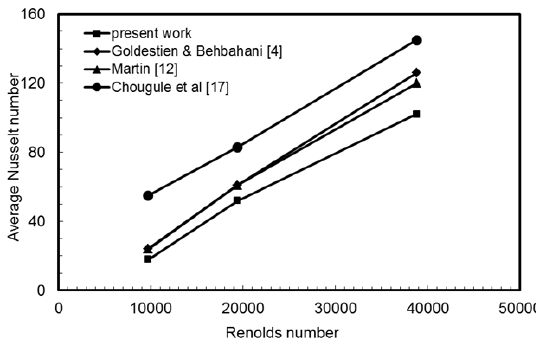
Figure 10. Comparison of Average Nusselt numbers with the previous work.